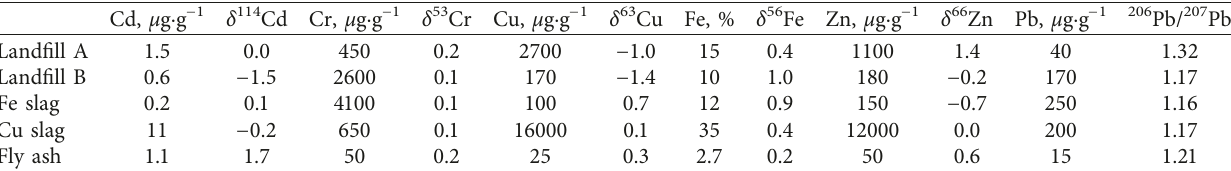
Table 13: Concentration and isotopic data for two contaminated soils (landfill A and landfill B) and waste samples from local industries (Fe, Cu slag, and fly